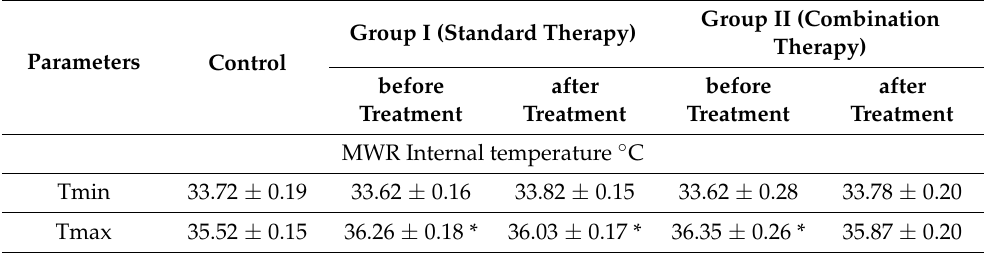
Table 2. Indicators of deep temperature in the lumbar region with various methods of treatment of patients with LBP (M ±